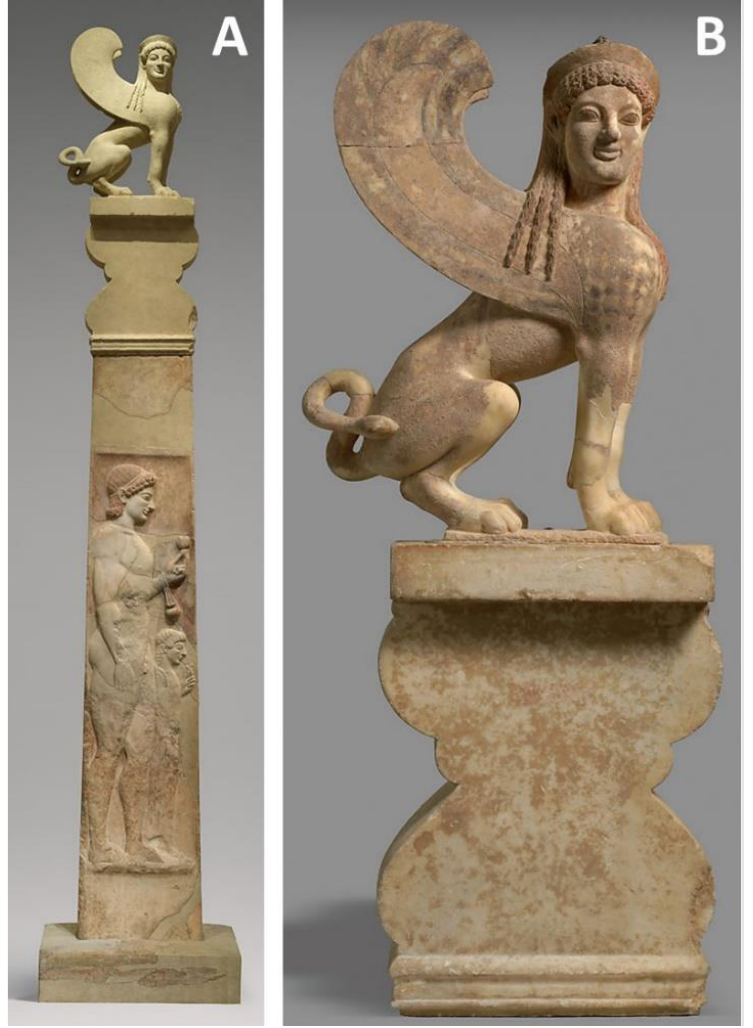
Figure 1. Marble stele with a youth and little girl, and a capital and finial in the form of a sphinx (11.185a–d, f, g, x). ( A ) Overall view; ( B ) Marble capital and sphinx. Greek, Attic, ca. 530 BCE. The Metropolitan Museum of Art, New York.